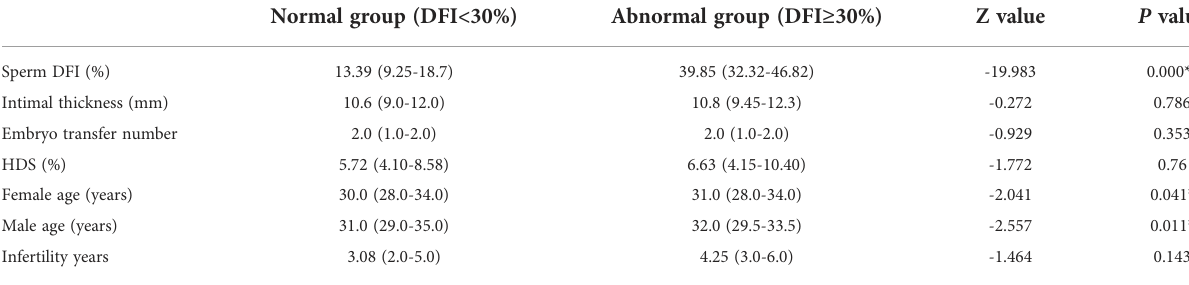
TABLE 4 Comparison of related parameters between the normal DFI group and abnormal DFI group in frozen embryo transfer cycles.